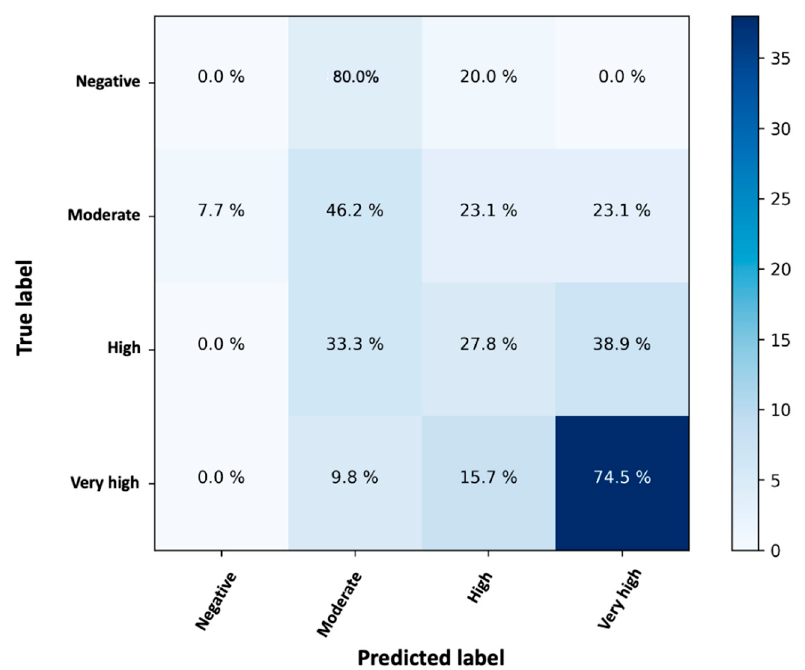
Figure 5. Confusion matrix of the random forest classifier to indicate the percentage of correct or incorrect predictions. The labels “negative”, “moderate”, “high”, and “very high” refer to neutralizing antibody levels (0–30%), (30–50%), (50–75%), (>75%).